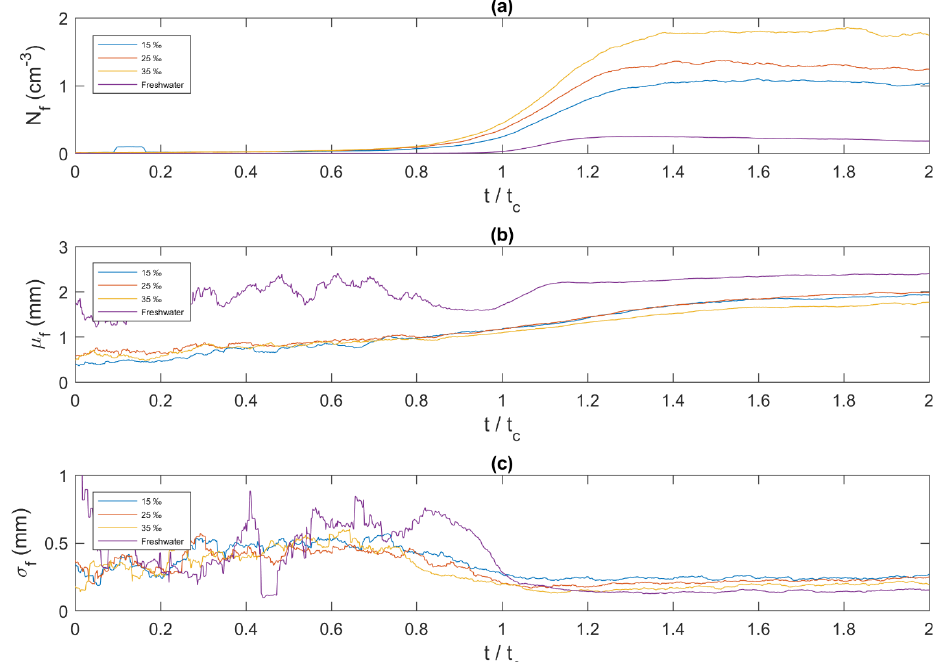
Figure 12. Ensemble-averaged time series of floc properties for all four salinities plotted as a function of dimensionless time. (a) N f , the average floc concentration (cm − 3 ) (b) µ f , the mean size of flocs (mm) and (c) σ f , the standard deviation of the size of flocs (mm). t/t c = 1 corresponds to the time of the minimum temperature on the supercooling